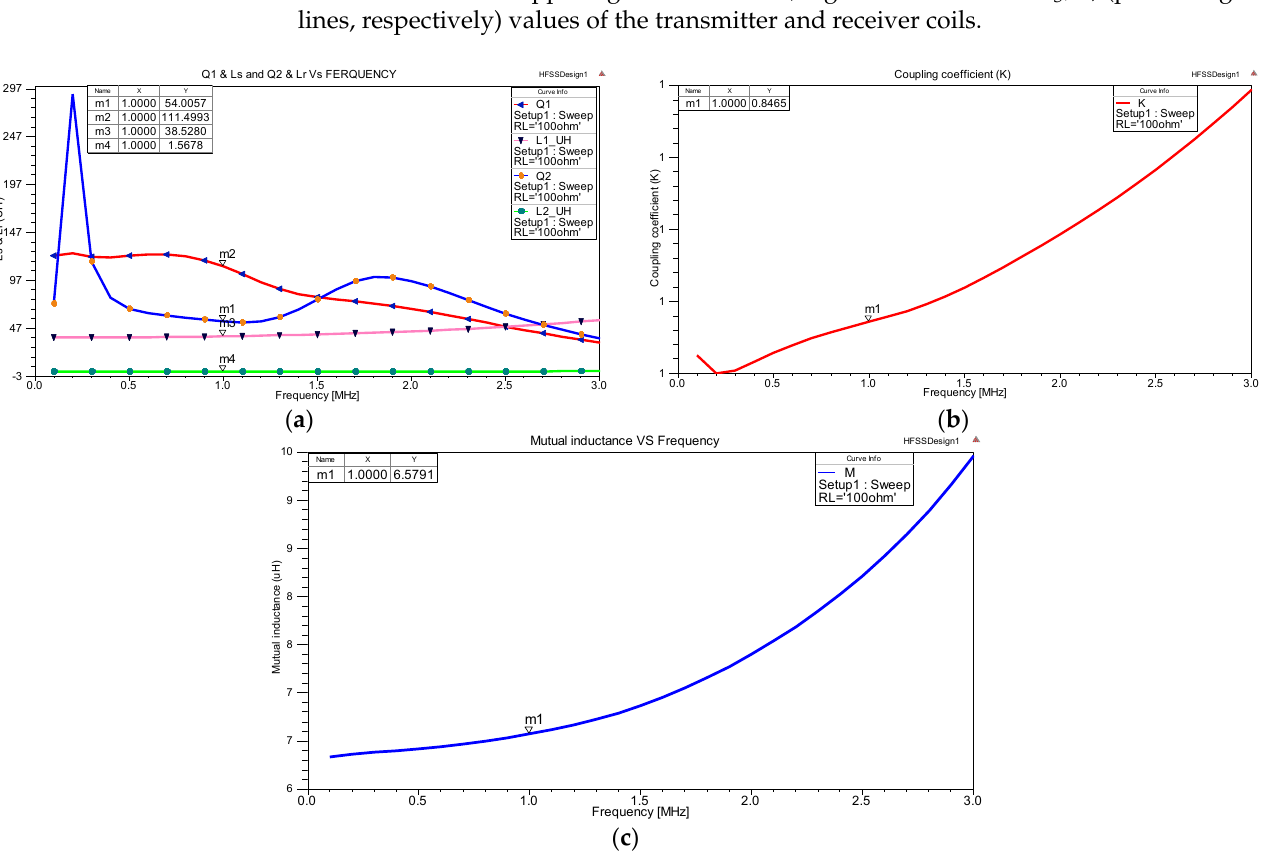
Figure 12. The results of the simulation of vertical alignment for 2 cm transfer distance: ( a ) Q 1 , Q 2 and L s , L r of transmitter and receiver coils, ( b ) k , and ( c ) M of MRC WPT.